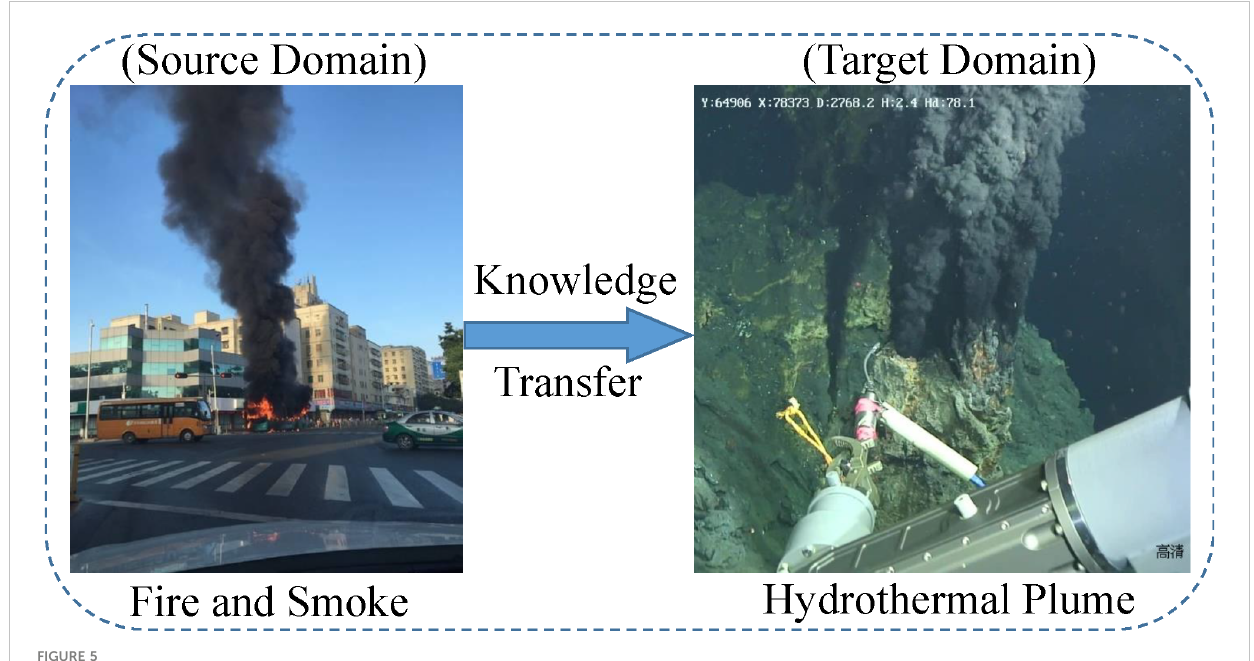
FIGURE 5 Schematic diagram of the knowledge transfer.